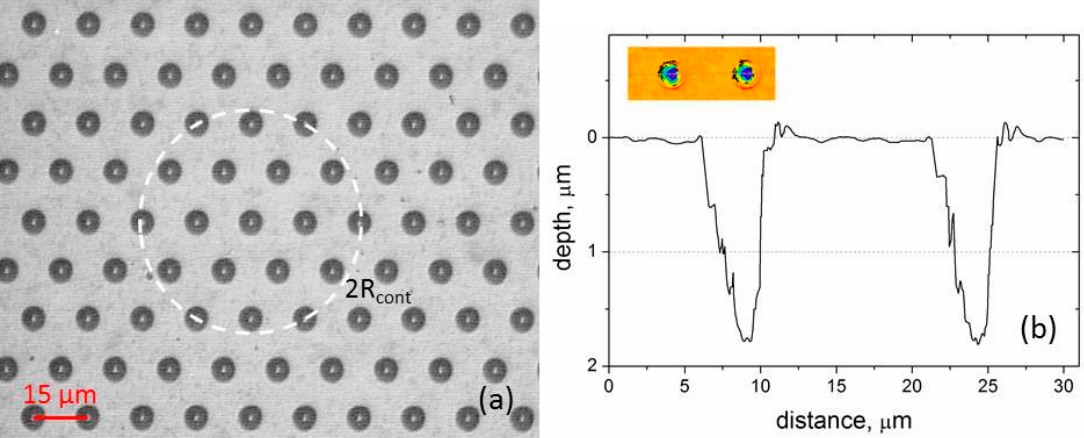
Figure 5. ( a ) OM image of the fs-laser-textured surface of the DLN film on steel substrate, and ( b ) WLI images and surface profiles of microcraters. The dashed circle with the diameter equal to 2 R cont shows the contact area between the DLN film and Si 3 N 4 ball at the beginning of sliding.